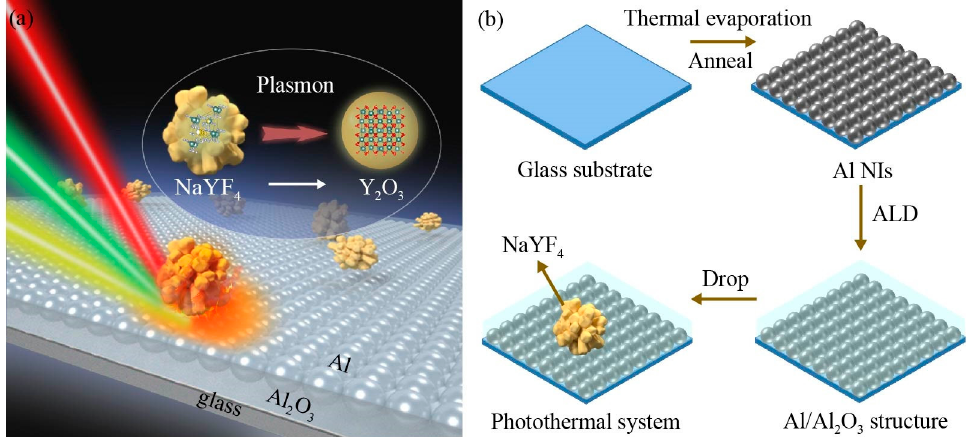
Figure 1. ( a ) Schematic illustration of the fast transformation of nanocrystals driven by the plasmonic photothermal system with a multi-wavelength response. ( b ) Preparation process of the plasmonic photothermal